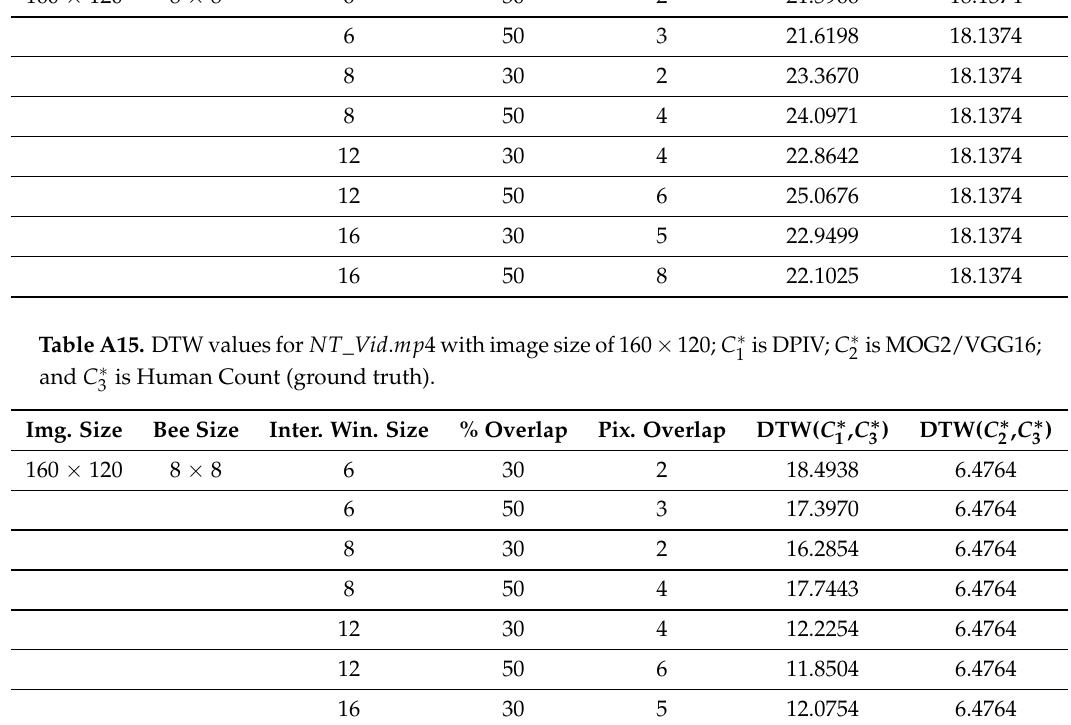
is DPIV; C ∗ is MOG2/VGG16; 2 1